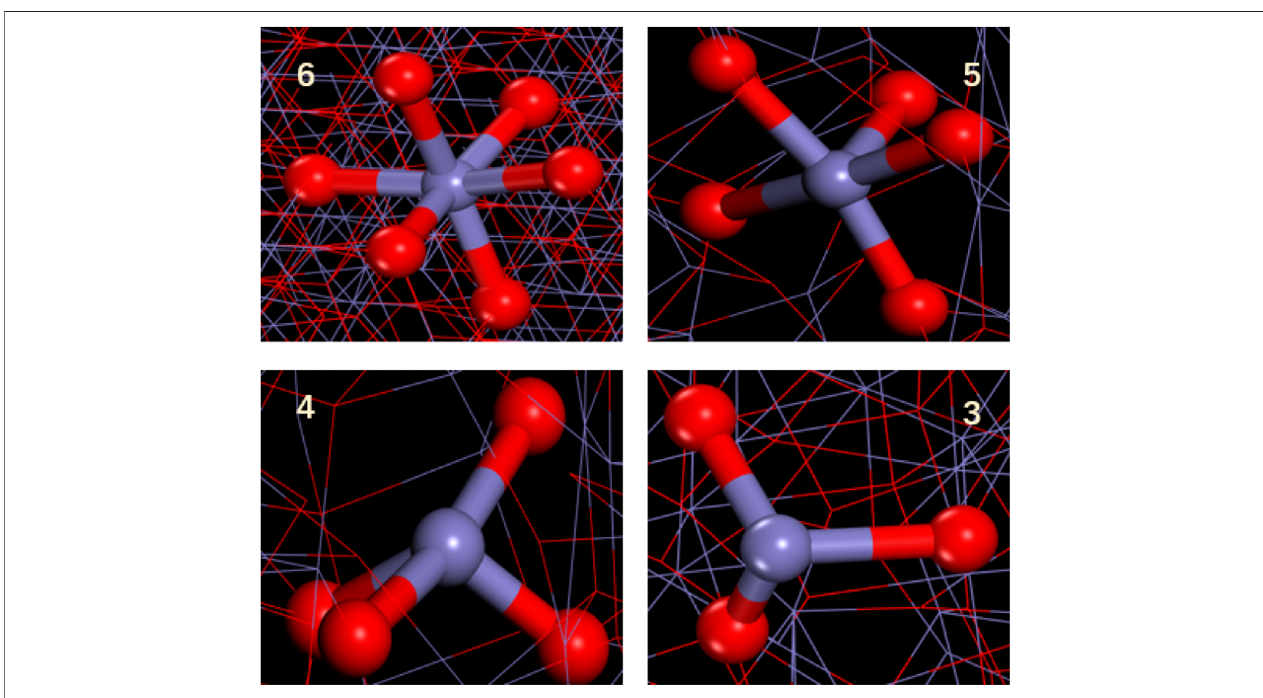
FIGURE 9 | Local structure diagram of Fe with different coordination in γ -Fe 2 O 3 . Color scheme: purple (cid:2) Fe; red (cid:2) O.